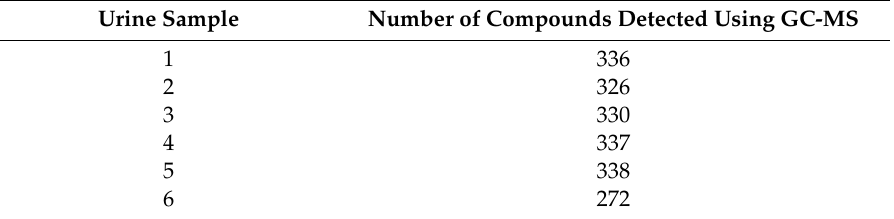
Table 3. The number of deconvoluted peaks detected in urine samples from six apparently healthy individuals by GC-MS